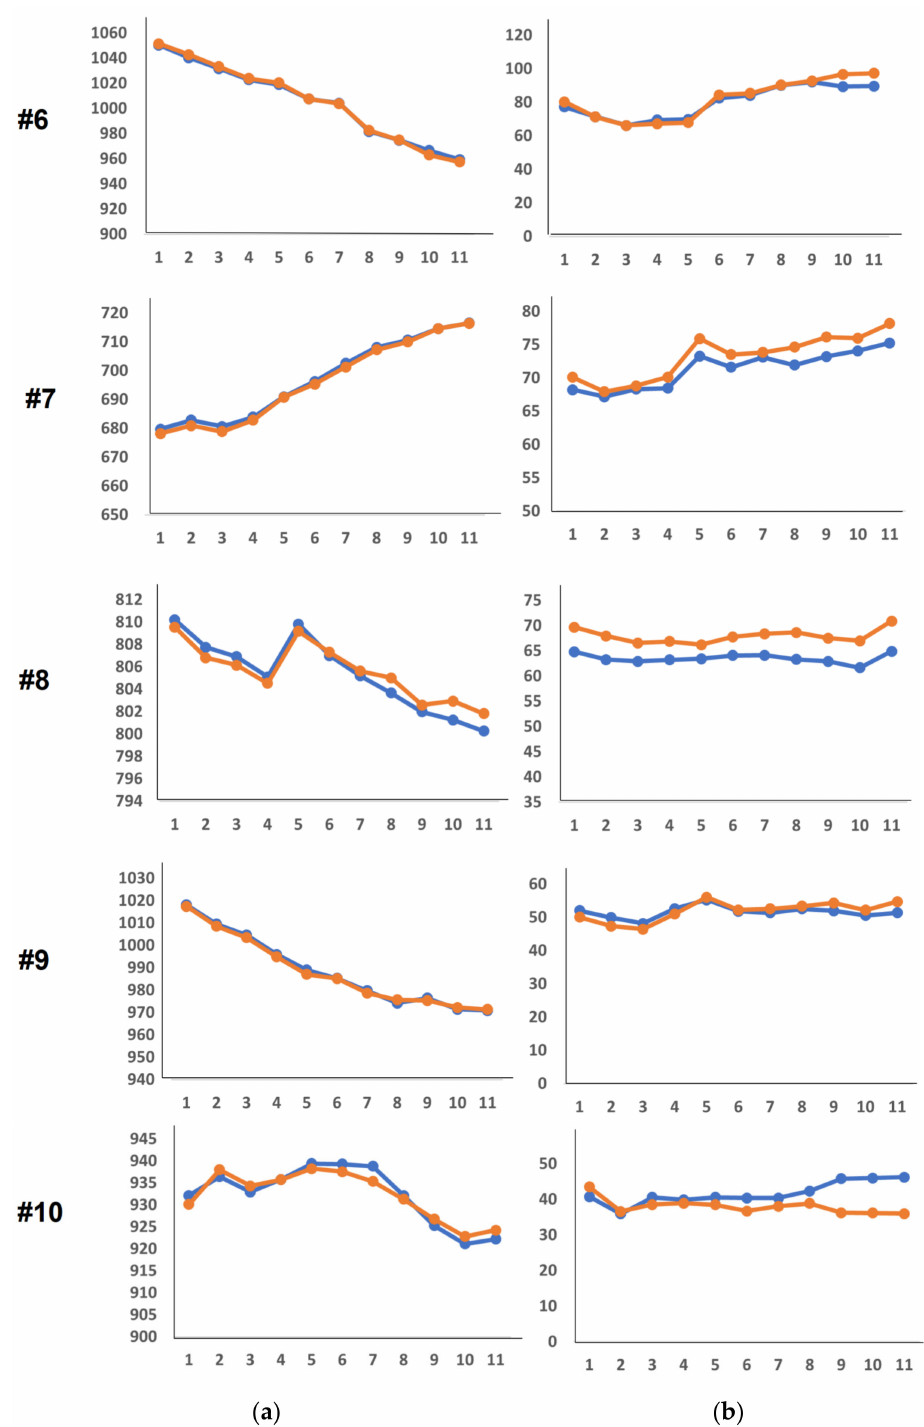
Figure 4. Pulse rate variability (PRV) time domain feature graphs of 10 subjects (( a ): Mean normal-to- normal (NN), ( b ): standard deviation of NN